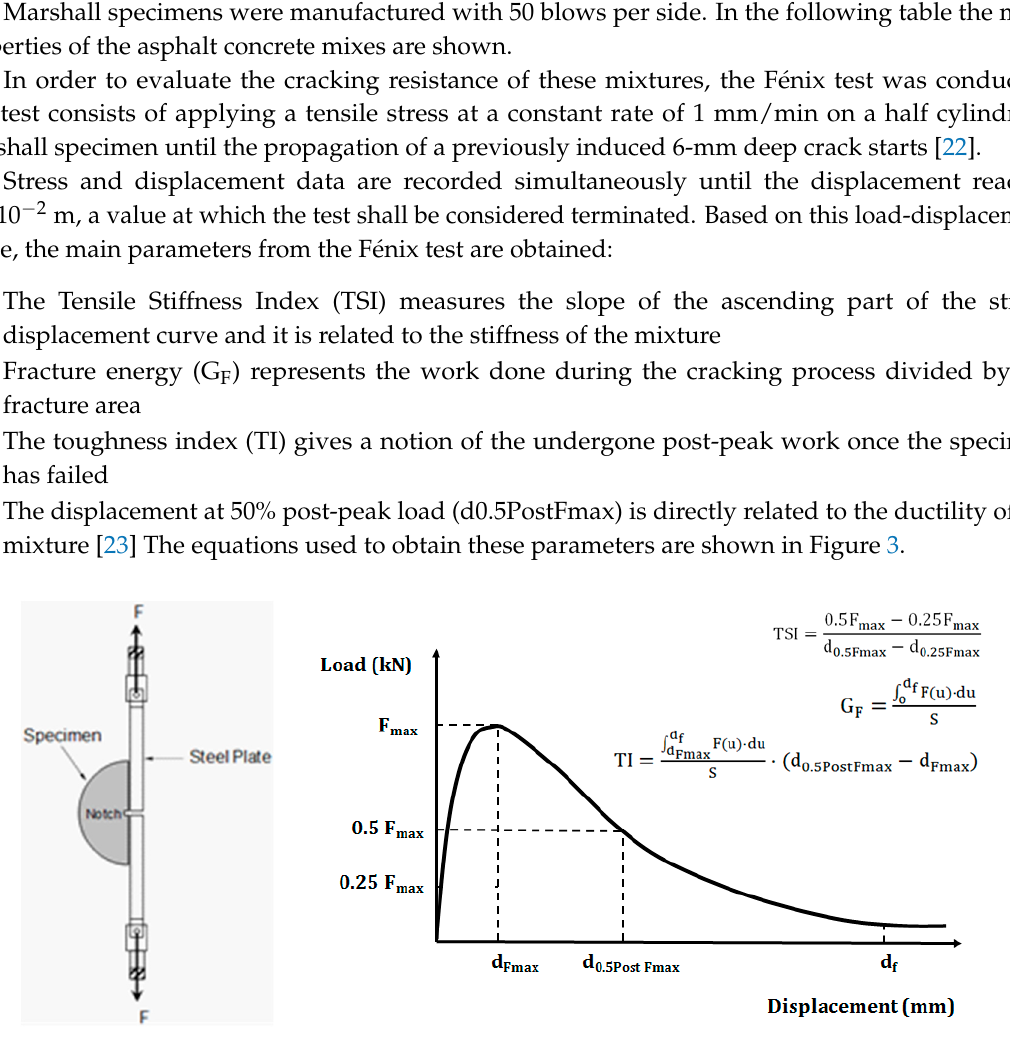
Figure 3. F é nix test set-up and stress-displacement output Figure 3. Fénix test set-up and stress-displacement output curve .